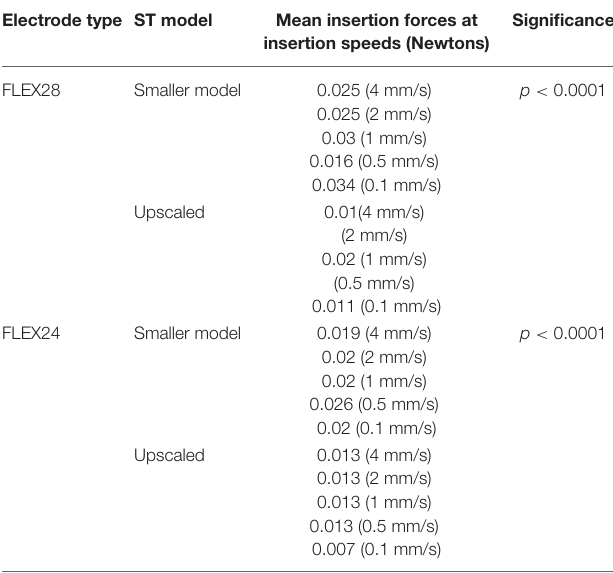
TABLE 3 | Mean insertion forces for FLEX28 and FLEX24 electrodes inserted at various insertion speeds in two different sized ST models. Electrode type ST